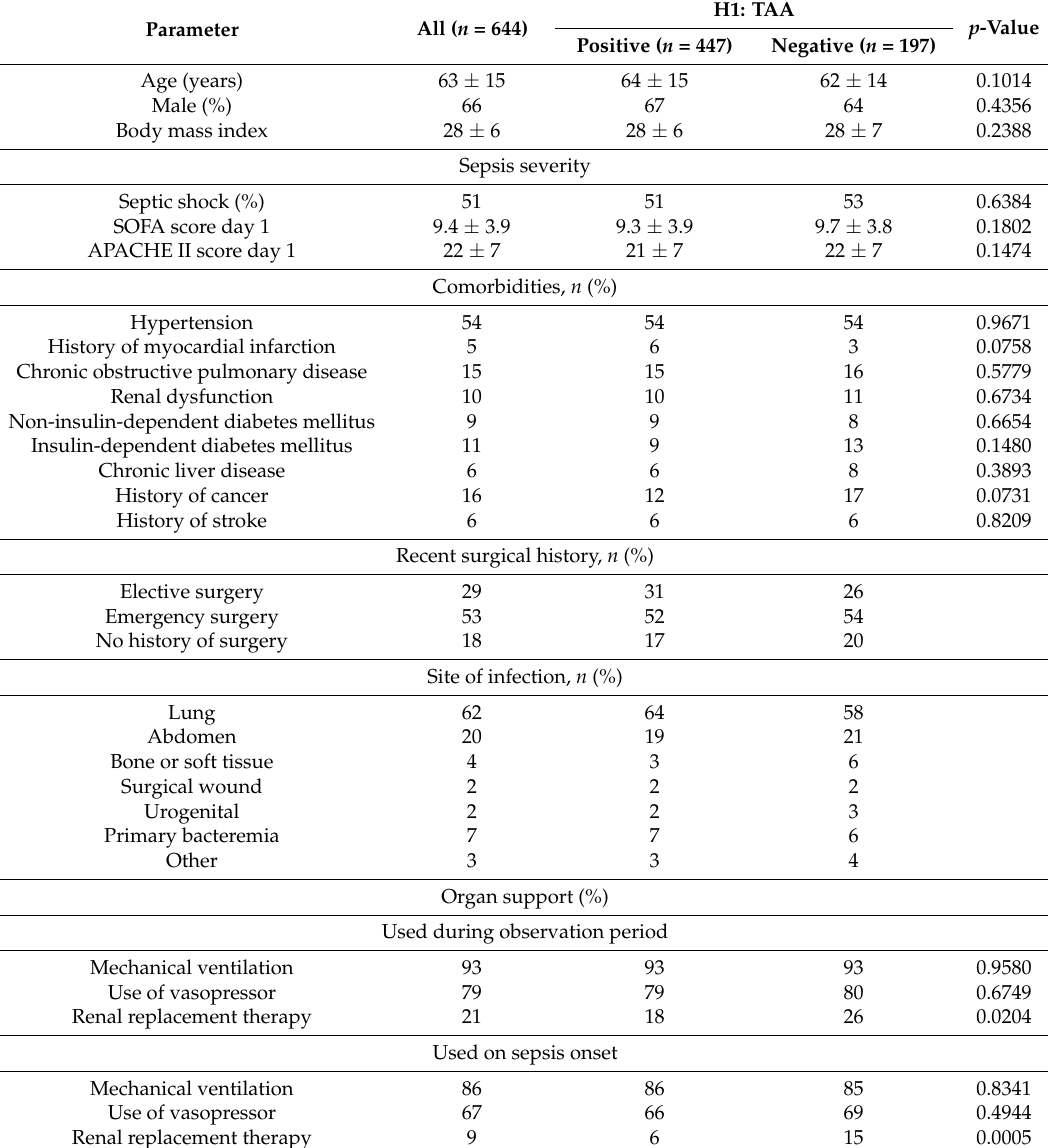
Table 2. Patient baseline characteristics with regard to the CTLA-4 haplotype H1: